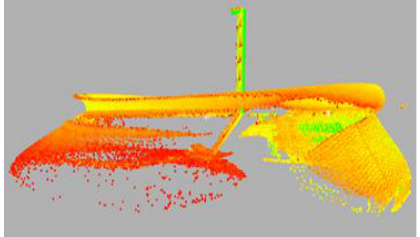
Figure 12. 3 D laser scan before refraction correction for Trial 2 [35,36] (used with permission).